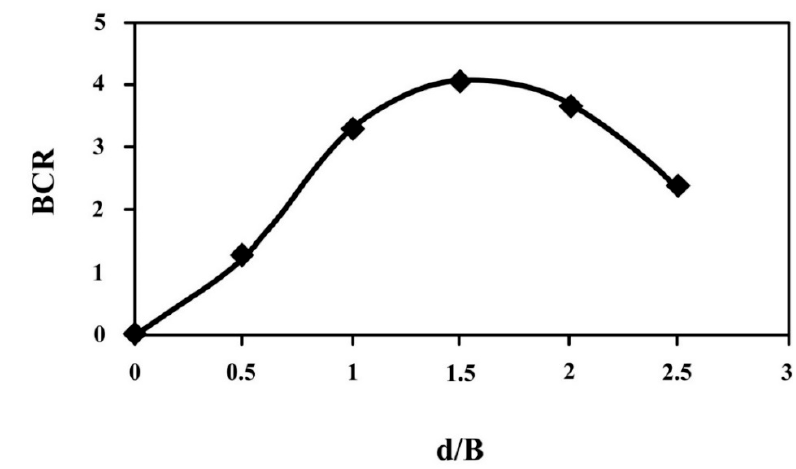
Figure 15. Comparison of the load settlement behaviour of bamboo-grid-reinforced soil and coir geonet (modified from Mathew and Sasikumar [35]).